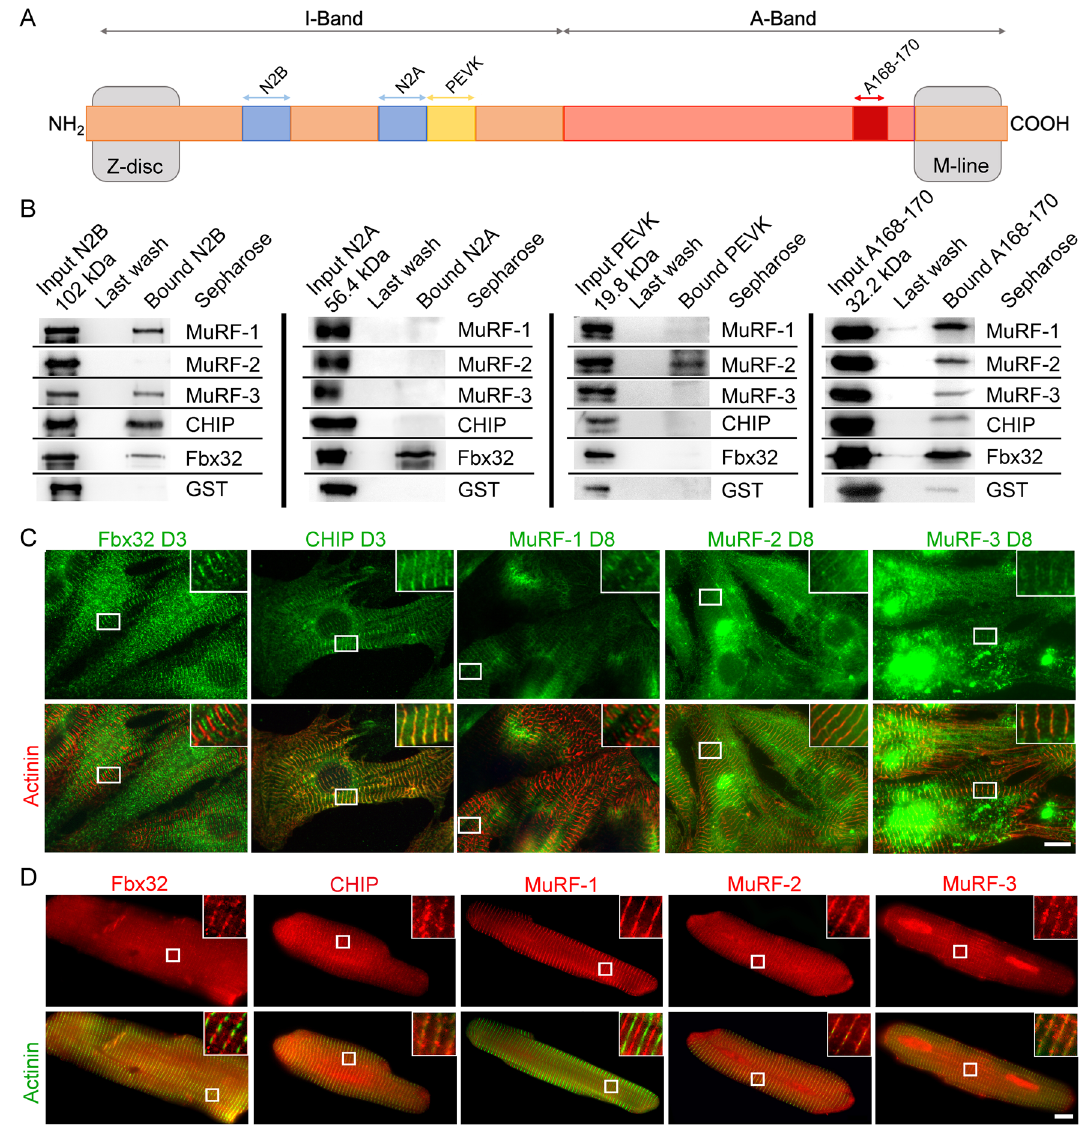
Figure 2. E3-ligase interaction with the titin filament. ( A ) Schematic overview of the titin filament including the analyzed domains, N2B, N2A, PEVK and A168-170. ( B ) In vitro pull-down interaction tests of muscle specific E3-ligases with several titin domains from the I-band and the A-band. Representative images shown for all combinations of interaction tests, including GST controls. Calculated molecular weights of the recombinant titin fragments are shown. Immunofluorescence analysis of E3-ligase localization in ( C ) embryonic and ( D ) adult rat cardiomyocytes under standard cultivation conditions. Insets in C and D show magnifications of E3-ligase and actinin localization. D3 or D8 = cultivation day 3 or 8. Bar = 10 affected by MuRF-1, -2 and -3 or Fbx32/CHIP siRNA treatment without additional inhibition of proteasome or autophagy, but we observed a strong variability in total titin: actinin ratio within groups (Fig. 3B). We hypoth- esized that at this time of cultivation ERCs have already differentiated to a more adult state. This maturation involves the loss of proliferative ability leading to a substantial reduction in the degradation and synthesis of sarcomeric proteins. In support of this hypothesis we stained for the cell cycle marker Ki67 (Suppl. Fig. 4B) and found an almost complete loss of Ki67 staining after 8 days. Additional inhibition of autophagy or the proteasome did not reduce ubiquitination of cardiomyocyte protein within the molecular weight range of 70–250 kDa (Fig. 3C). In contrast, levels of ubiquitinated titin were signifi- cantly decreased in cells with a knock down of MuRF-1, -2 and -3 under basal conditions (− 64.4% ± 9.43%), after inhibition of autophagy (− 69.3% ± 2.91%) and proteasomal activity (− 66.6% ± 8.37%) (Fig. 3D/E). In cells with a knock-down of CHIP and Fbx32 we determined significantly lower titin ubiquitination levels after inhibition of autophagy (-33.9% ± 4.56%), but not under basal conditions or after inhibition of the proteasome (Fig. 3D/E). To more specifically characterize the E3-ligases we treated cells with single siRNAs targeting either MuRF-1, -2, -3, CHIP or Fbx32 (Fig. 4A/B). In contrast to the knock-down of all three MuRFs single siRNA treatment